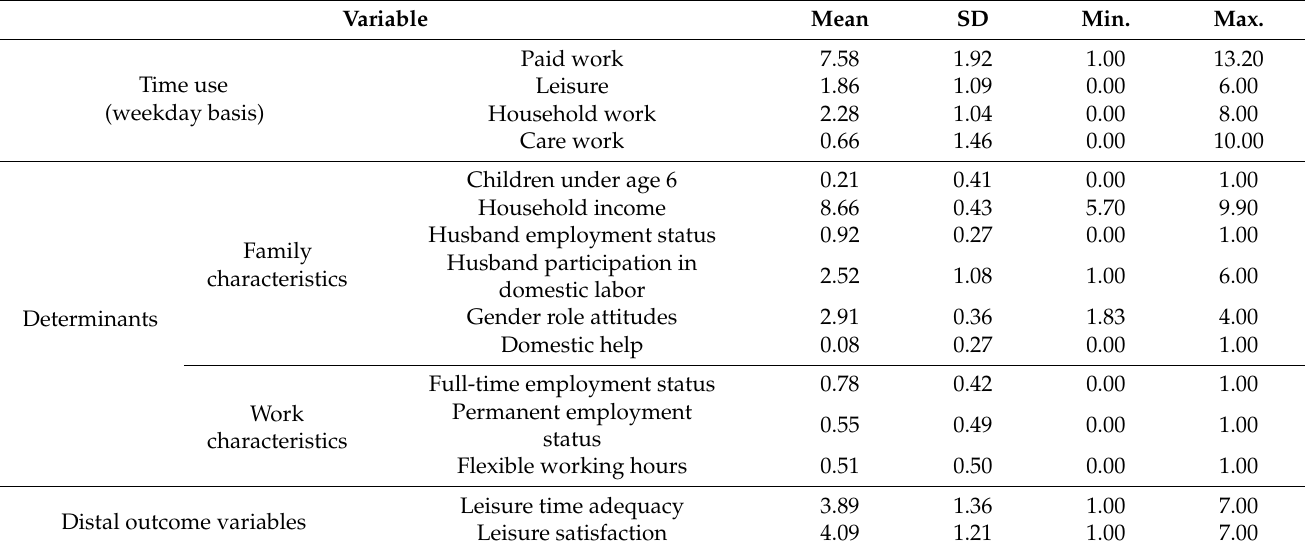
Table 2. Descriptive statistics of variables ( N =